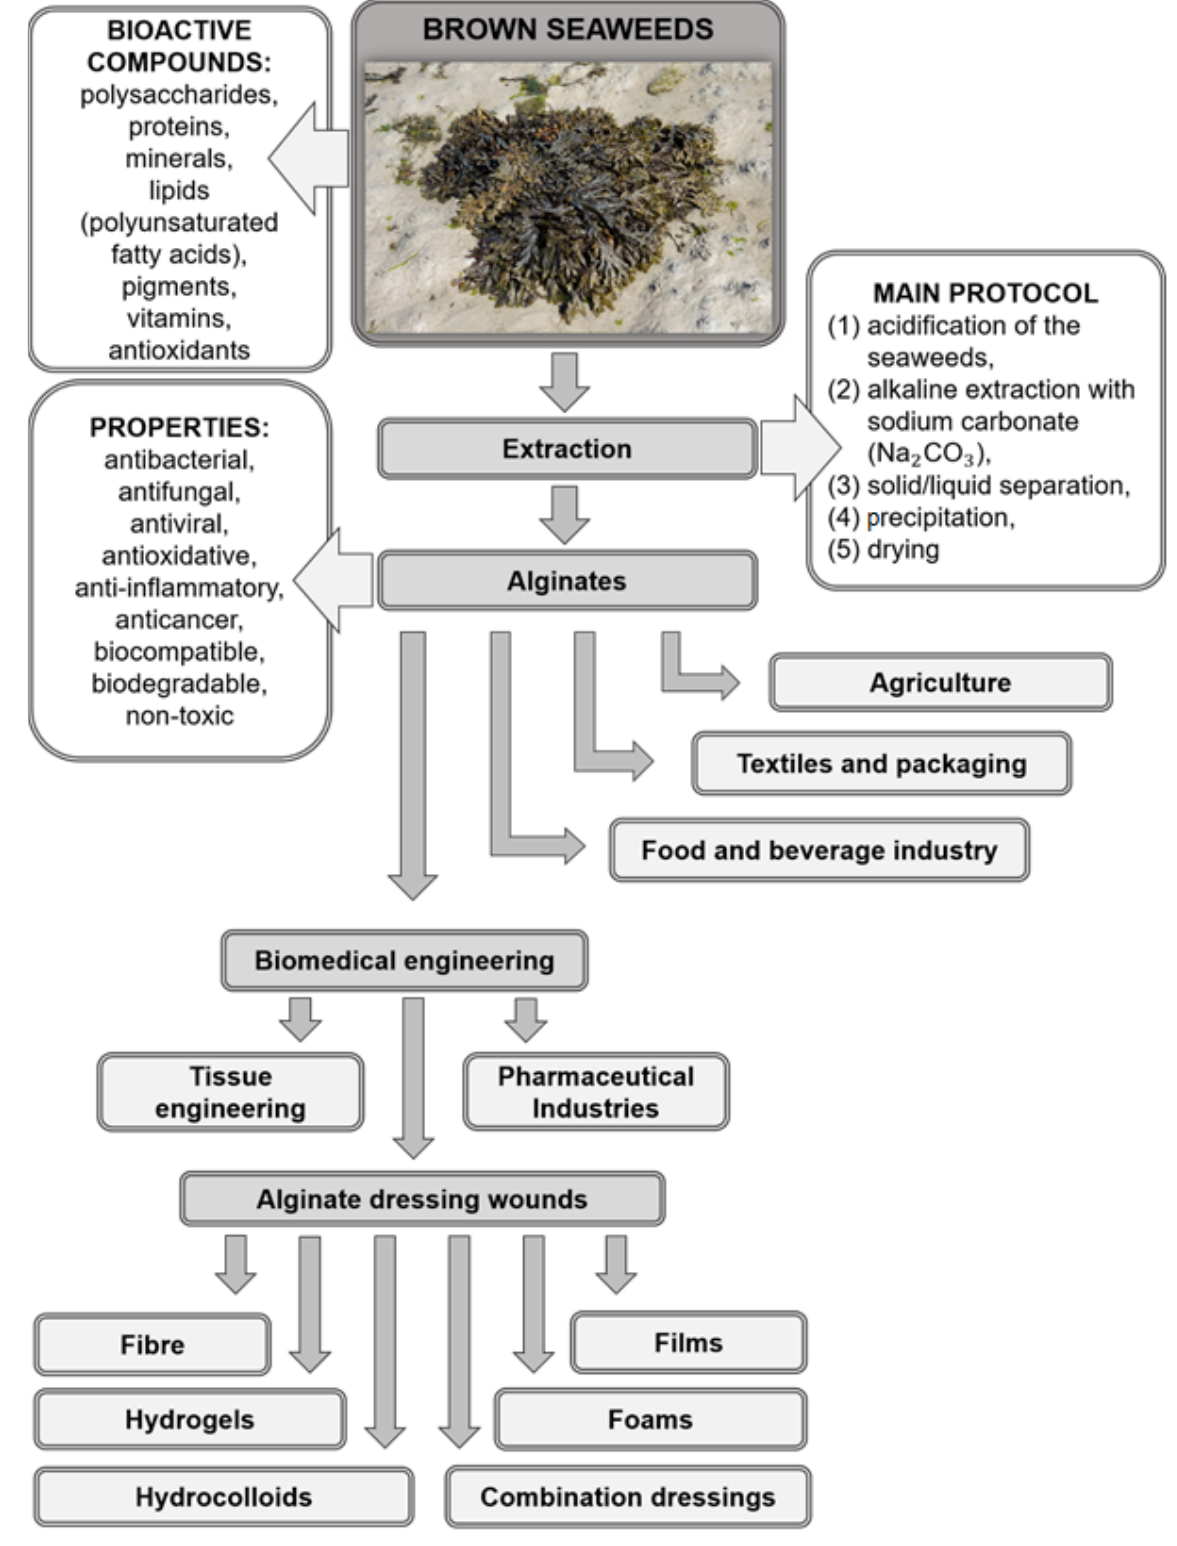
Figure 2: Alginates processing scheme with potential